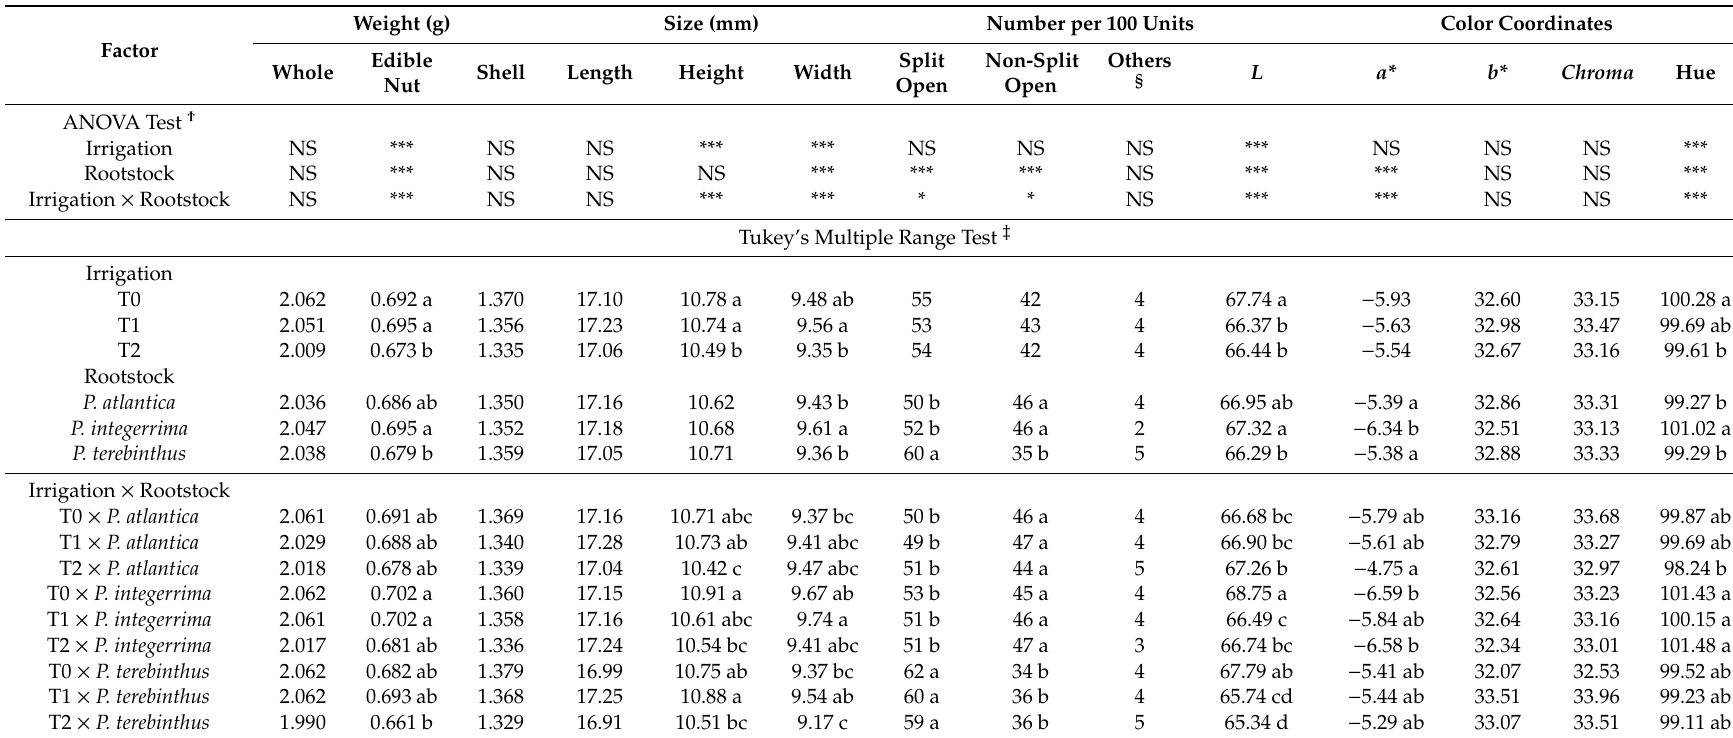
Table 6. Weight, size, and nature of pistachios as a ff ected by deficit irrigation treatment and